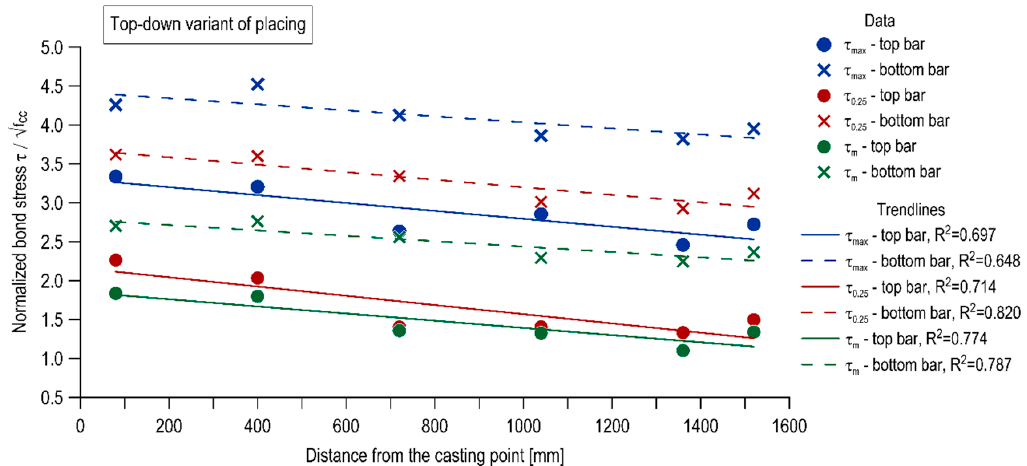
Figure 11. Effect of distance from casting point in the top-down variant of placing. Figure 11. E ff ect of distance from casting point in the top-down variant of